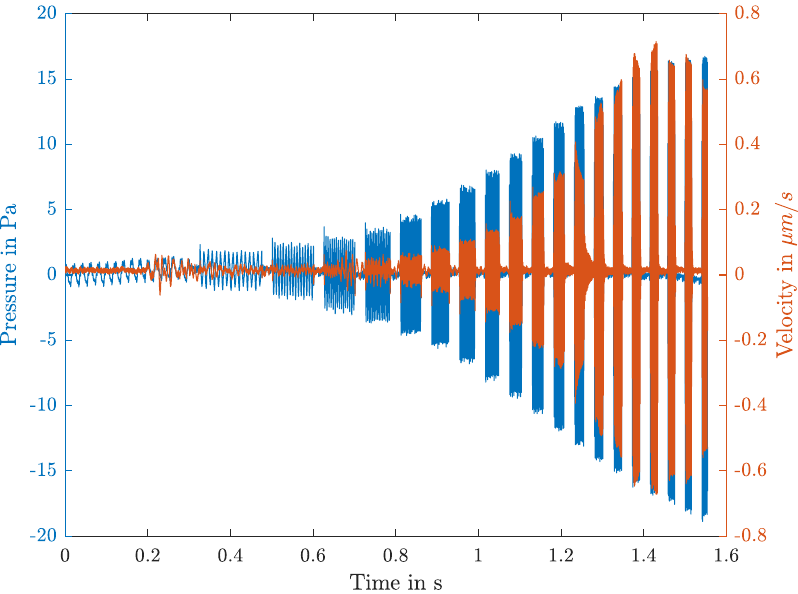
Figure 5. The applied pressure signal (blue) and resulting surface velocity (orange) plotted over time. The pressure signal excites the tissue at each frequency from 50–1000 Hz for 10 periods. The speaker driving voltage is kept constant, due to the speaker’s frequency-dependent sensitivity the pressure level is increasing.